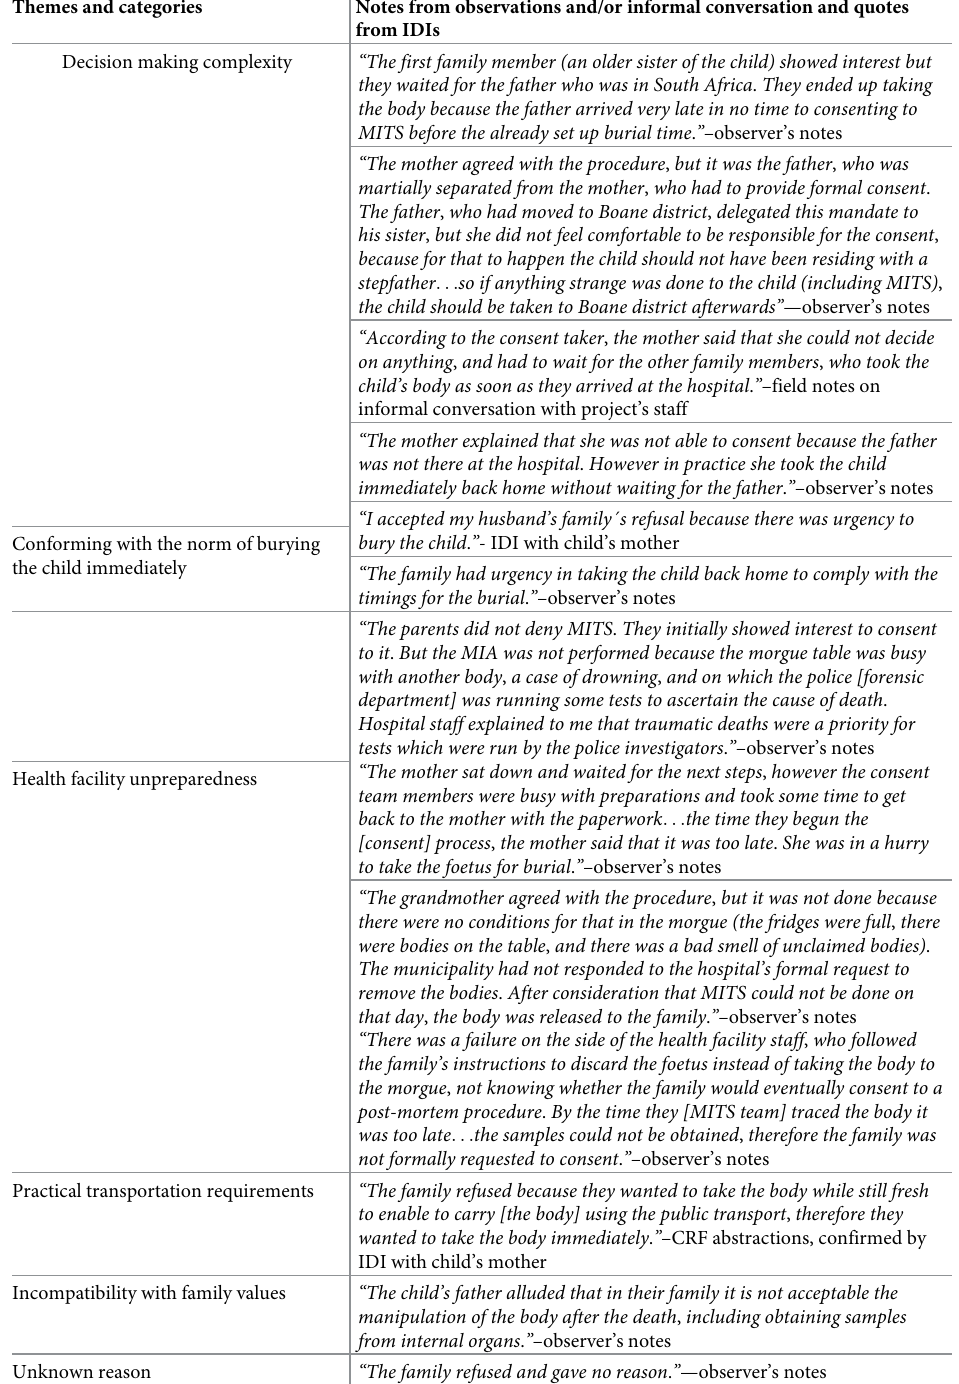
Table 6. Reasons for refusing MITS based on direct observation and health staff accounts of refusal cases (n =